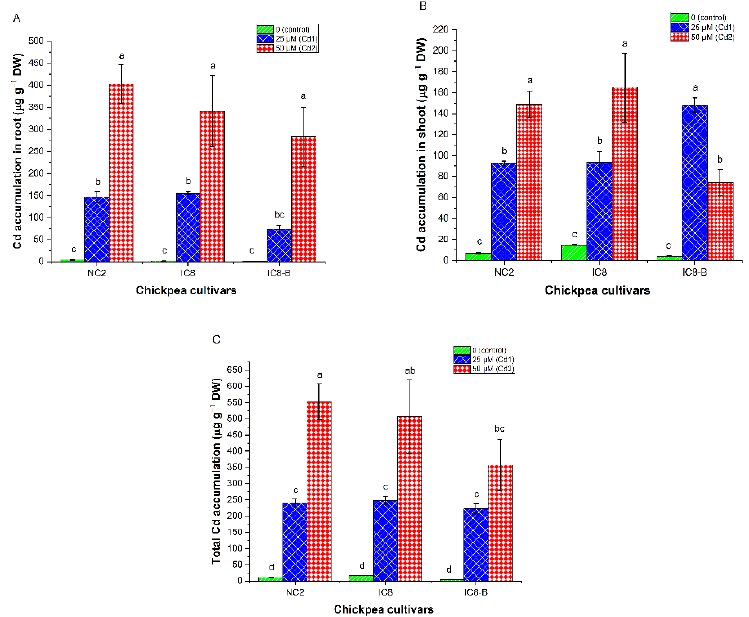
Figure 5. The accumulation of Cd in the root ( A ), shoot ( B ) and total Cd accumulation ( C ) in chickpea cultivars (NC2, IC8 and IC8-B) grown under various concentrations of Cd (0, 25 and 50 µM). The bars represent SE, n = 3. Columns with different characters are significantly different according to (DMRT) at p < 0.05.